Question: What form of chart is displayed?
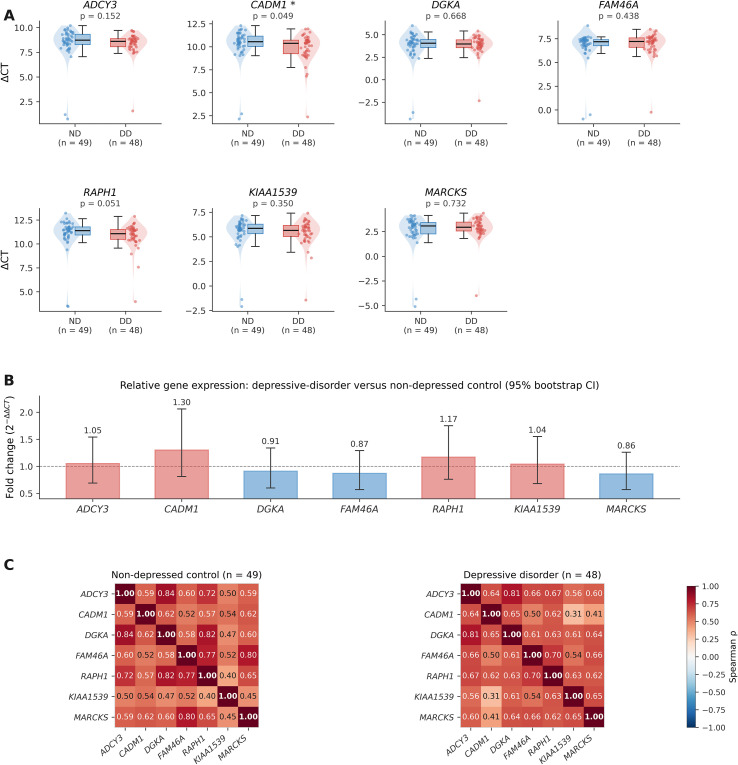
Answer: heatmap